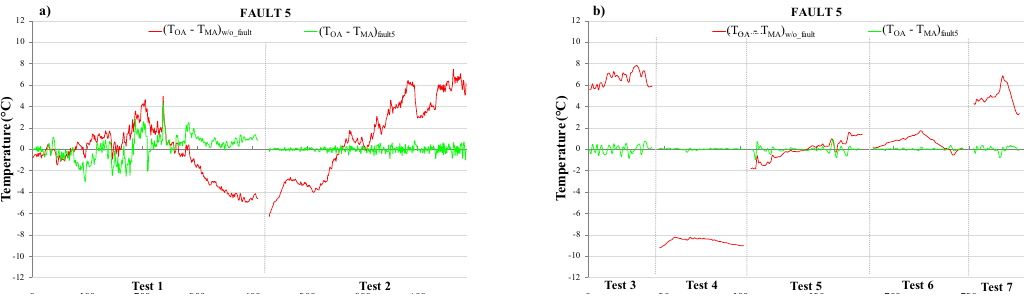
Figure 11. Comparison between normal operation and operation with fault 5: test 1, 2 ( a ), test 3, 4, 5, 6, 7 ( b ).